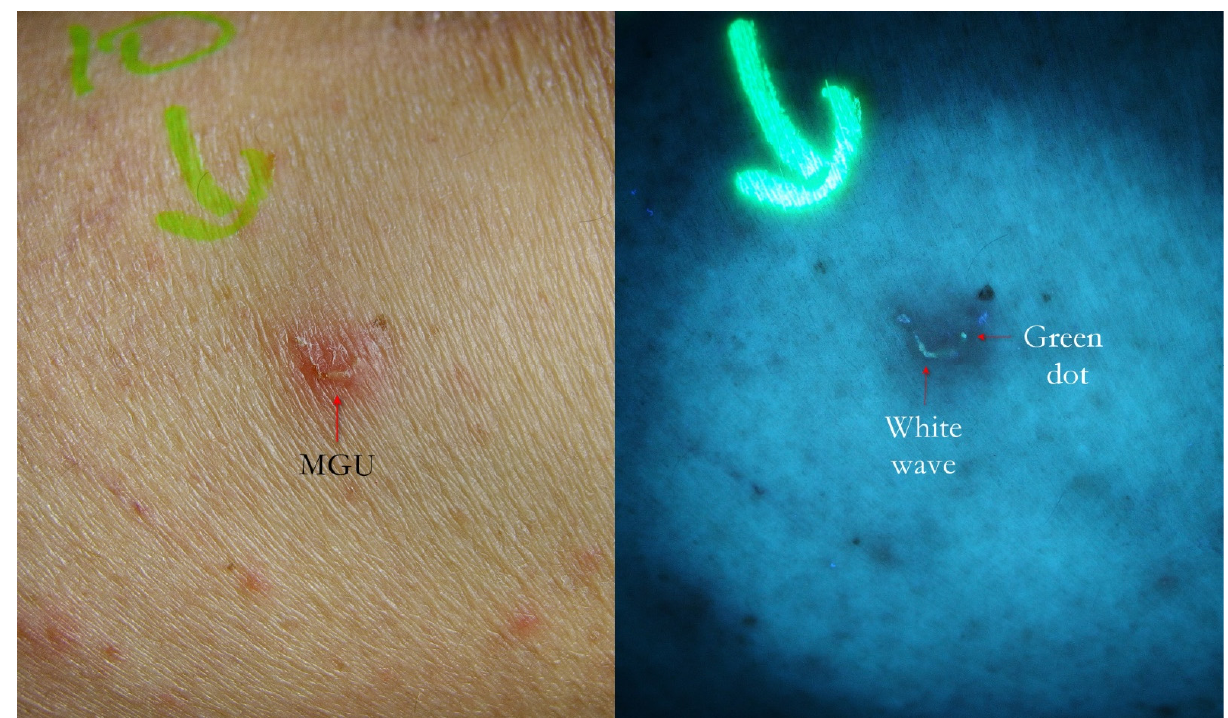
Figure 2. Flash light vs. UVA. A MGU was already recognizable to naked eye ( left ) as an apparent single structure. However, UVA light was able to distinguish body ‐ MGU (white wave) from head ‐ MGU (green ‐ dot) where Sarcoptes body was physically located ( right ). The red phlogosis halo around burrow returned a darker light than the rest of background. A yellow highlighter was used.